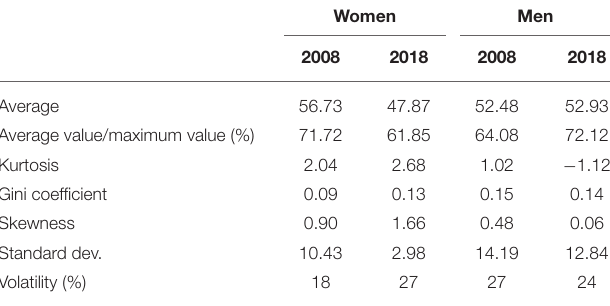
TABLE 7 | Retirement age in analyzed countries (in 2008 and